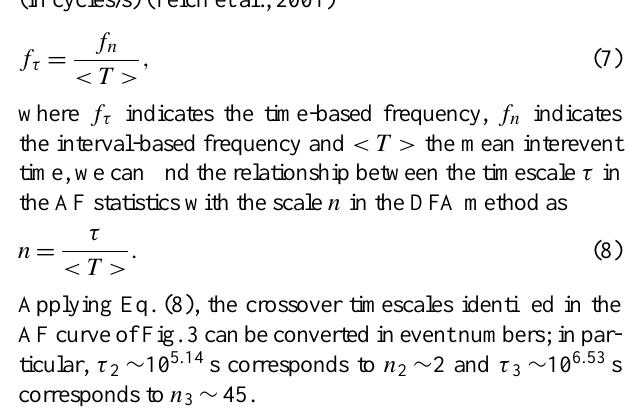
curve of the original sequence within the scaling range, and this indicates that the scaling behavior is due to the specific ordering of the interevent